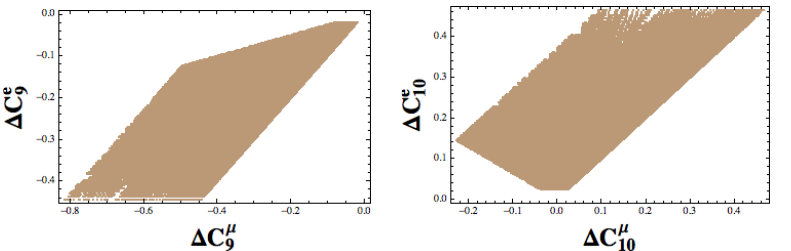
Figure 1. Scenario A : Plot show the correlation in the C 9 and C 10 parameter plane for both the electron and the muon. The bottom row gives the range of c b